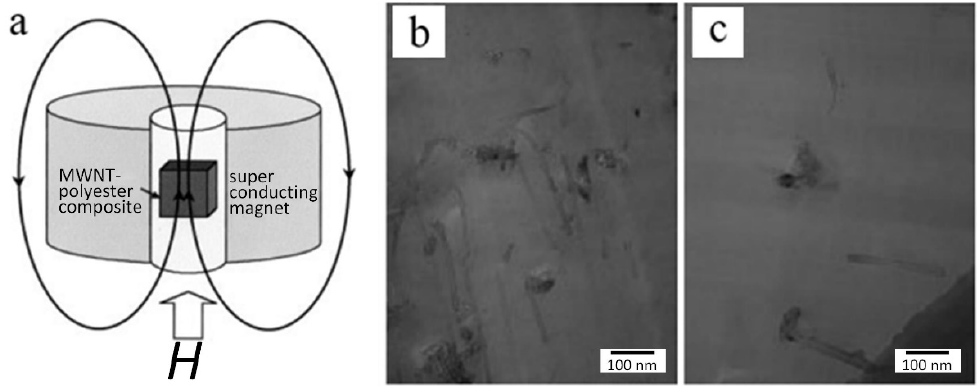
Figure 17. ( a ) Schematic of the alignment of CNTs in composite under magnetic field. TEM image of a thin film sliced ( b ) parallel and ( c ) perpendicular to the applied magnetic field. Reproduced with permission [116]. Copyright 2002, John Wiley and